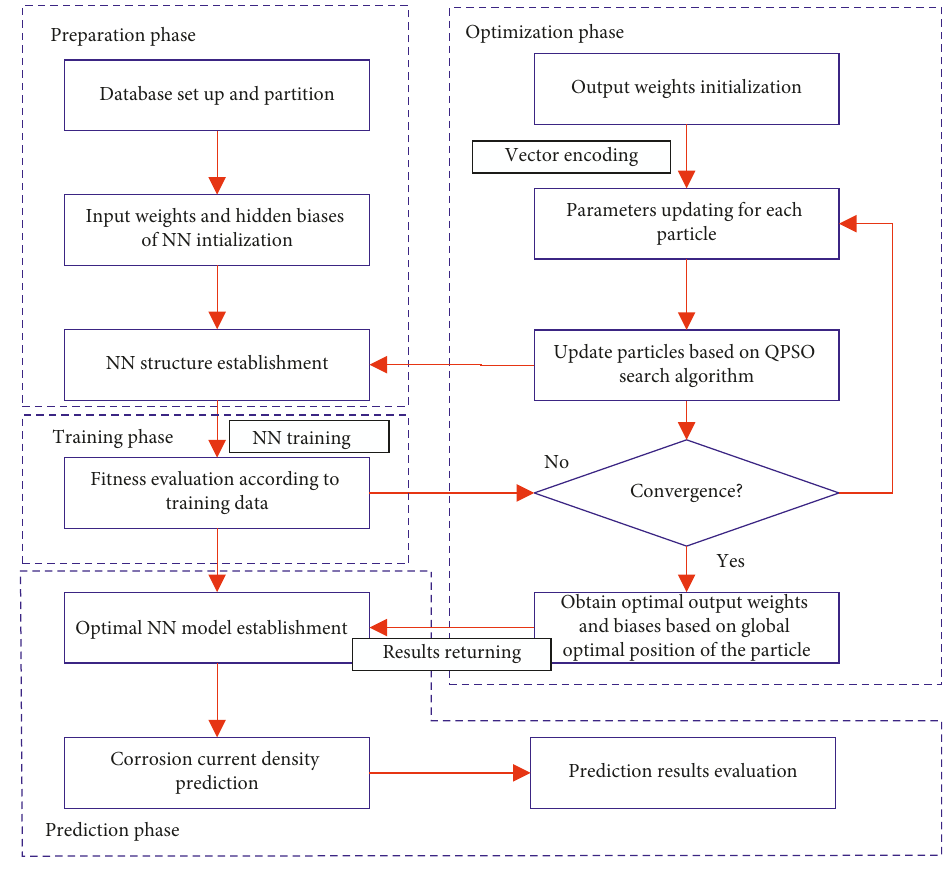
Figure 6: Structure of the ANN and encoding details in QPSO. Table 2: Parameters of the QPSO-ANN